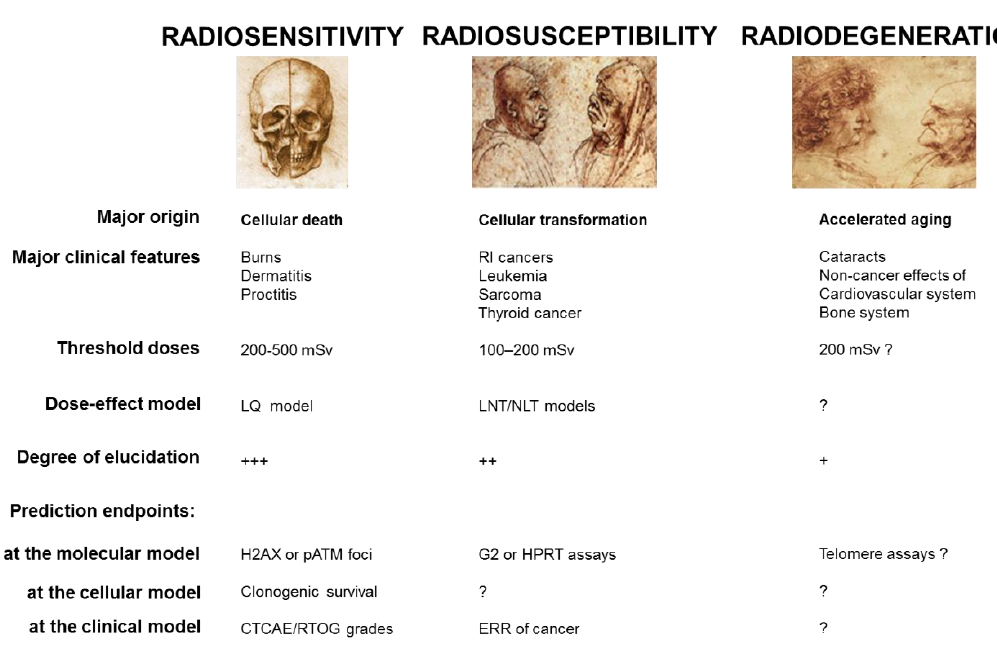
Figure 1. The major radiation-induced (RI) effects and their specific features. This figure aims to summarize the current basic knowledge of radiosensitivity, radiosusceptibility, and radiodegeneration. The threshold doses were reviewed in [2].